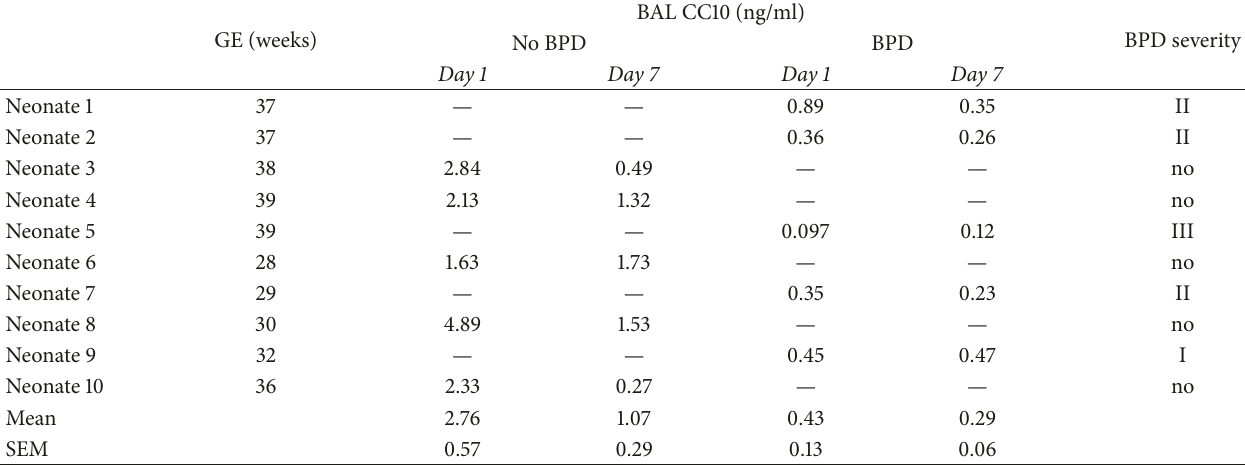
Table 2: BAL fluid CC16 concentration in ventilated term and preterm neonates from day 1 and day 7. GE